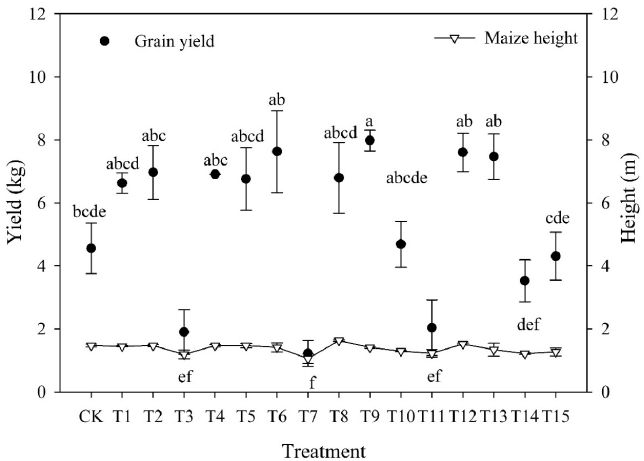
Figure 5. Effects of BC, FA and BS treatment on yield and height of maize. BC = biochar, FA = fulvic acid, BS = Bacillus subtilis . Different letters indicate significant differences between treatments at the p < 0.05 level.